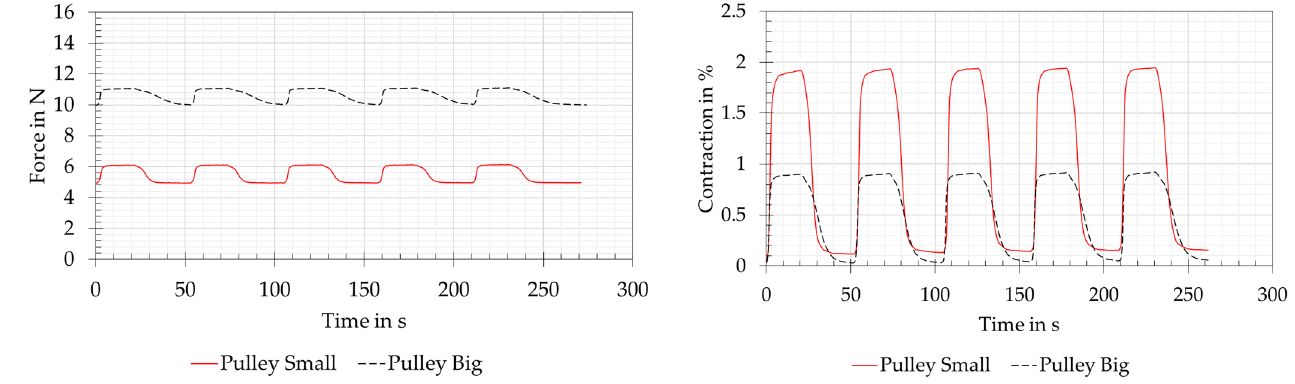
Figure 13. Pulley block version: force and contraction measurements for the small and big pulley variants. The wire length was 250 mm for the small pulley and 450 mm for the big pulley. The small pulley was supplied with 3 V and 0.7 A and was preloaded with 5 N. The big pulley was supplied with 5.4 V and 0.7 A and preloaded with 10 N.